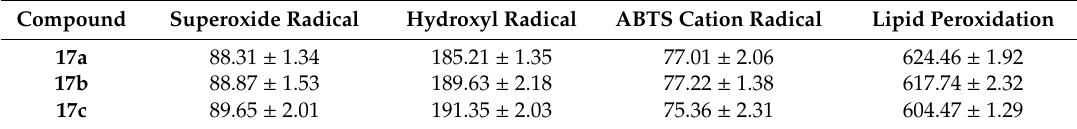
Table 9. IC 50 values of chloro-4-aminochalcones 17a , 17b , and 17c , expressed in µ g / mL.